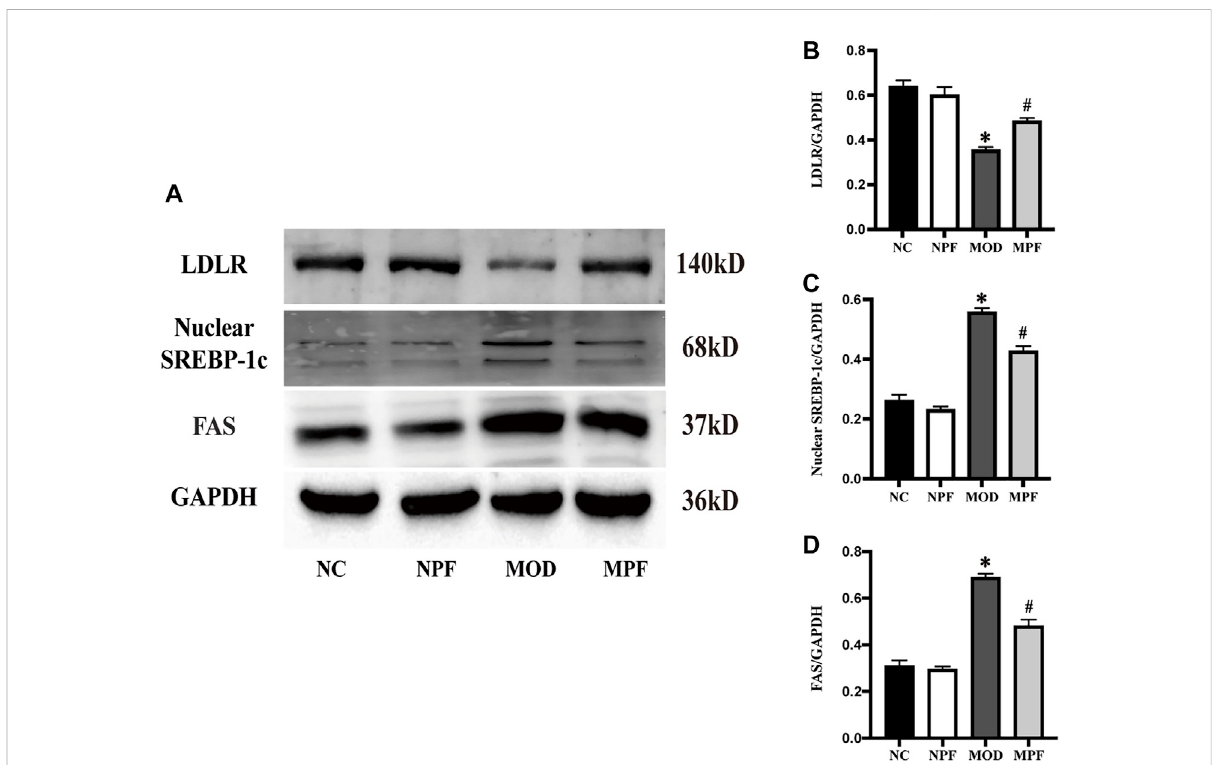
Effects of paeoni fl orin (PF) on protein expression related to lipid metabolism in the liver. (A) Representative LDLR, nuclear SREBP-1c, and FAS expression brands. (B – D) Grey value of western blotting bands. The liver samples were obtained from the normal control group (NC),